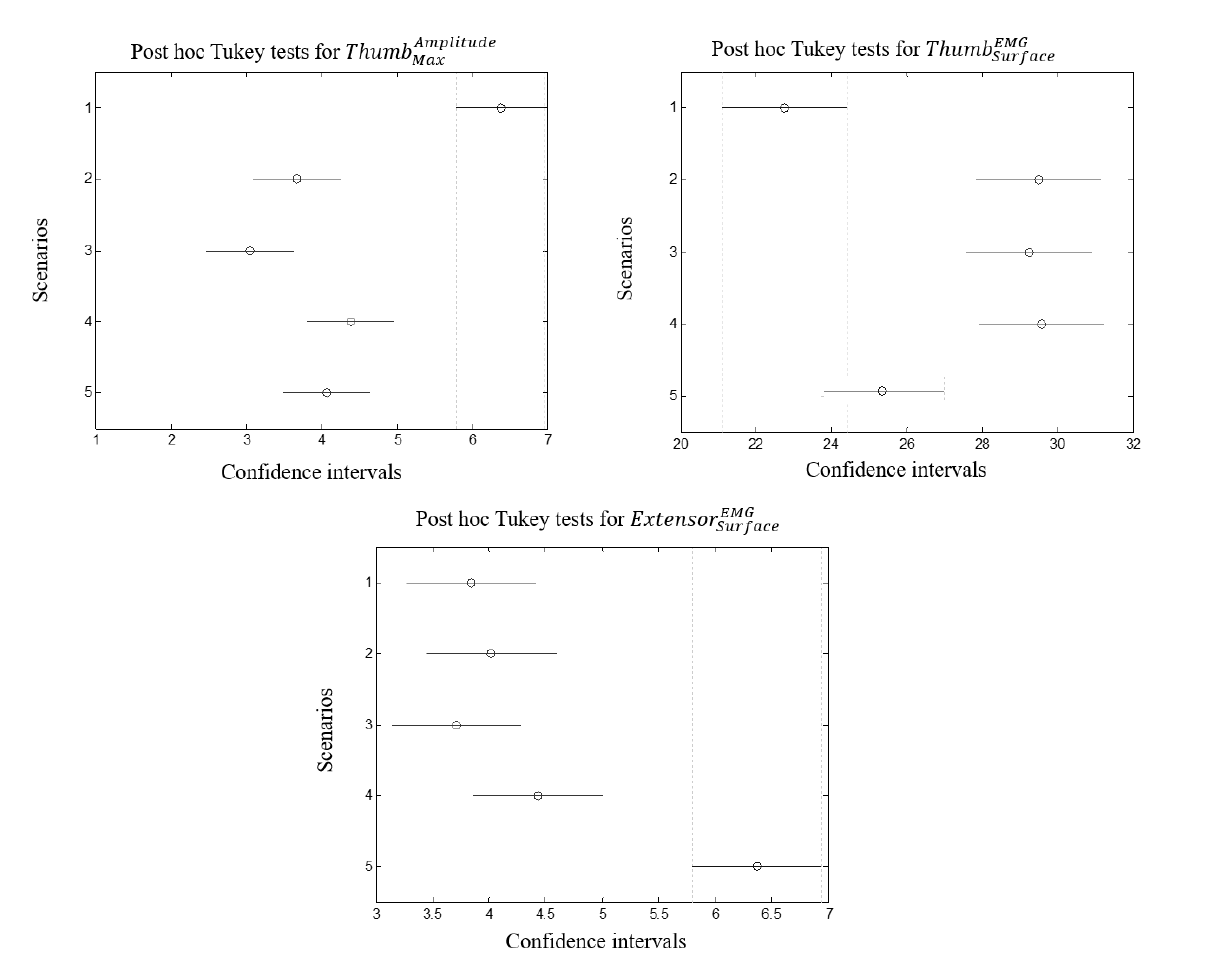
Figure 10. From left to right: differences between scenarios reported by Tukey tests for Thumb Amplitude Extensor EMG Surface